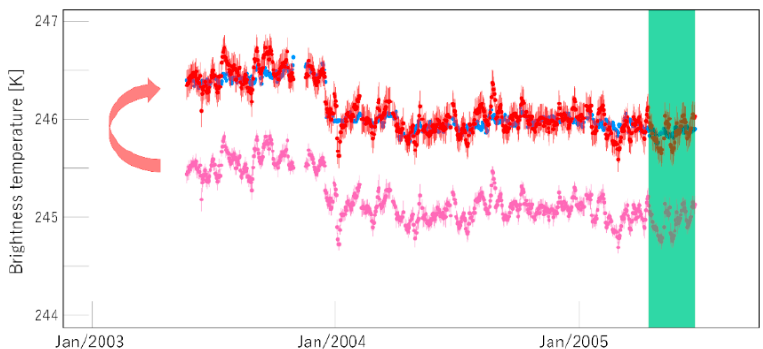
Figure 8. Recalibrated radiances equivalent to count 40 of GOES-9/Imager WV channel derived from recalibration coefficients by Aqua/AIRS (blue) and those by NOAA-14/HIRS2 (pink), and the prime corrected NOAA-14/HIRS2 (red) using Aqua/AIRS as the prime satellite. The green shaded region represents the period where data was used to compute the prime correction parameters.